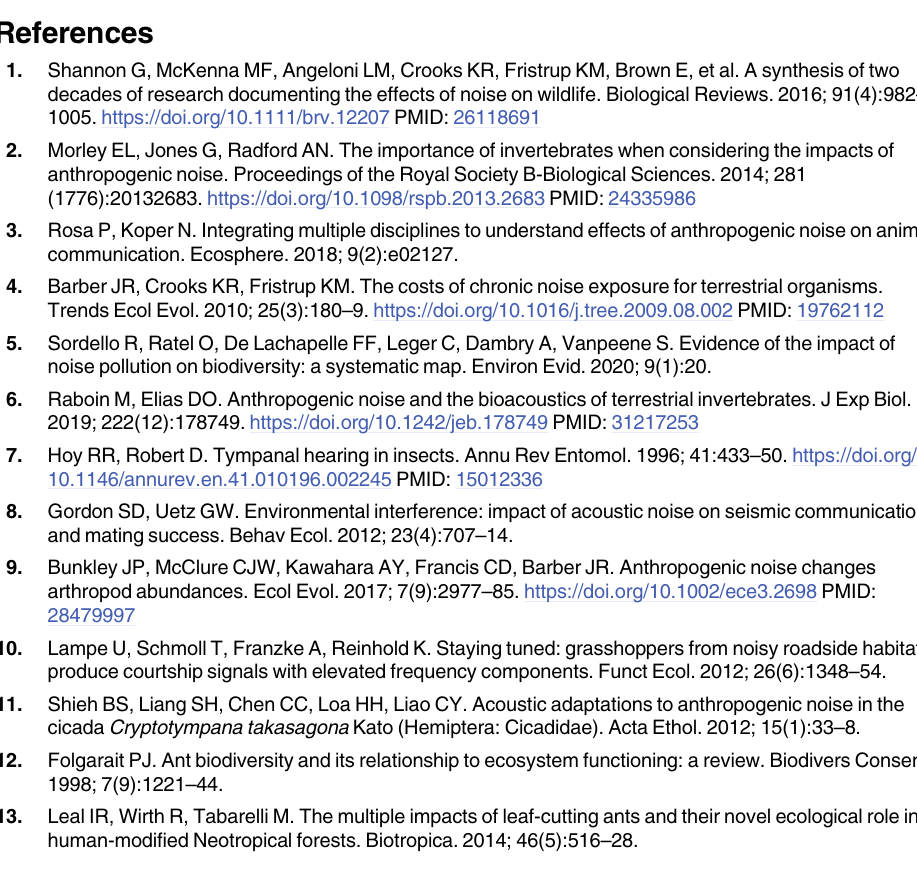
S1 Fig. Mean ( ± SD) of foraged leaf fragment A) surface area (cm 2 ) and B) dry mass (g) by A . octospinosus under noise and control treatments recorded across the ten experiment repli-